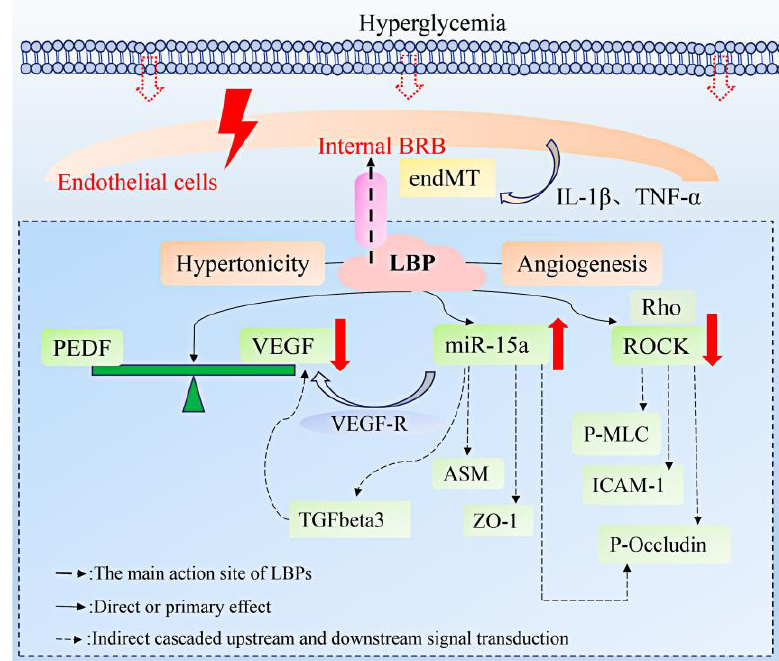
Figure 4. The mechanism of action of LBPs to improve diabetic retinopathy.